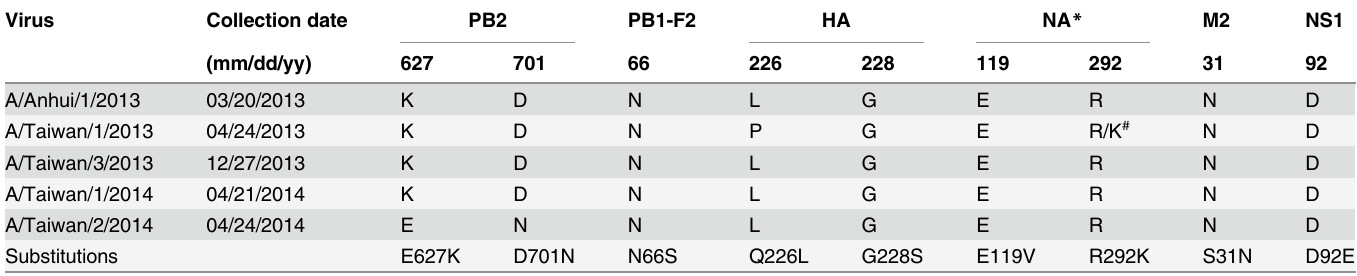
Table 4. Amino acid substitutions, associated with mammalian host adaptation, receptor binding and antiviral resistance, in the proteins of the four imported H7N9 viruses.